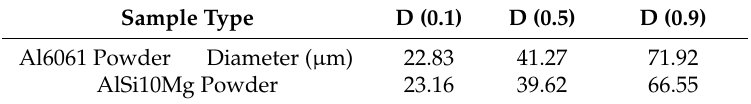
Table 4. Values measured for the particle size distribution of the Al6061 and AlSi10Mg powders.